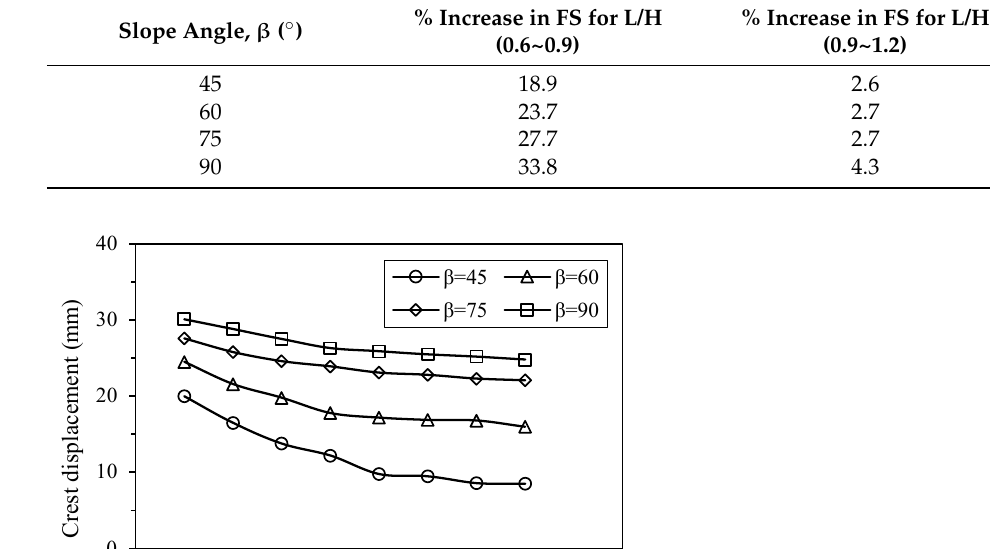
Table 3. Percent increase in FS with values of L/H for horizontal backslope. Slope Angle, β (°)